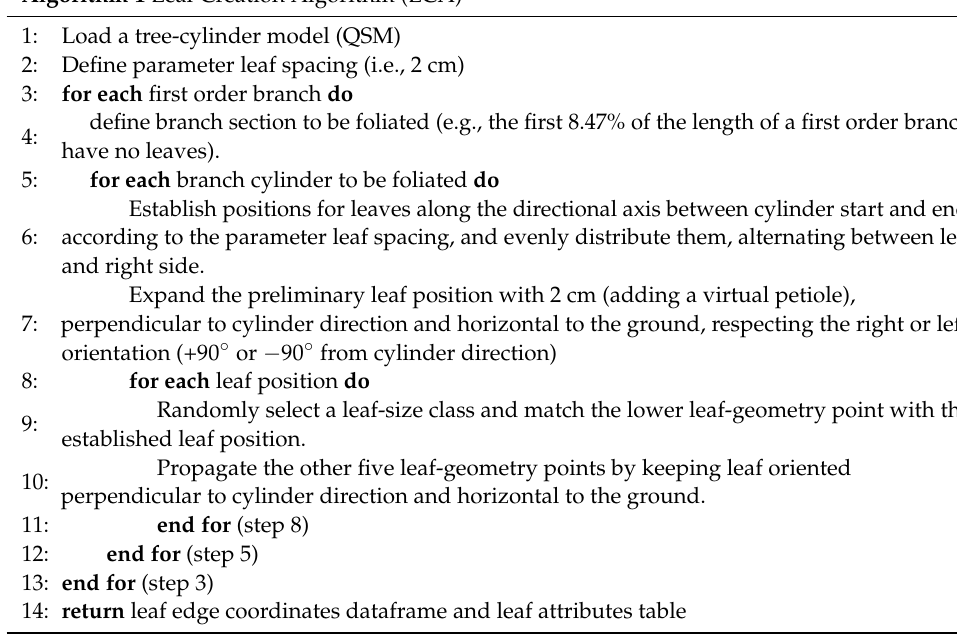
Algorithm 1 Leaf Creation Algorithm (LCA)